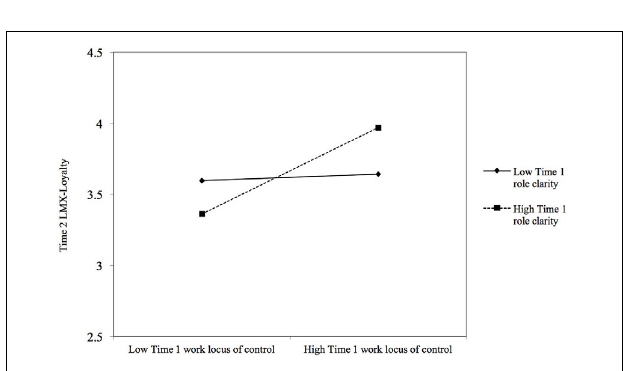
FIGURE 2 | Interaction between Time 1 work locus of control and Time 1 role clarity predicting Time 2 LMX-Loyalty, controlling for Time 1 LMX-Loyalty. Relationships are shown at 1 SD above and below the mean of Time 1 role